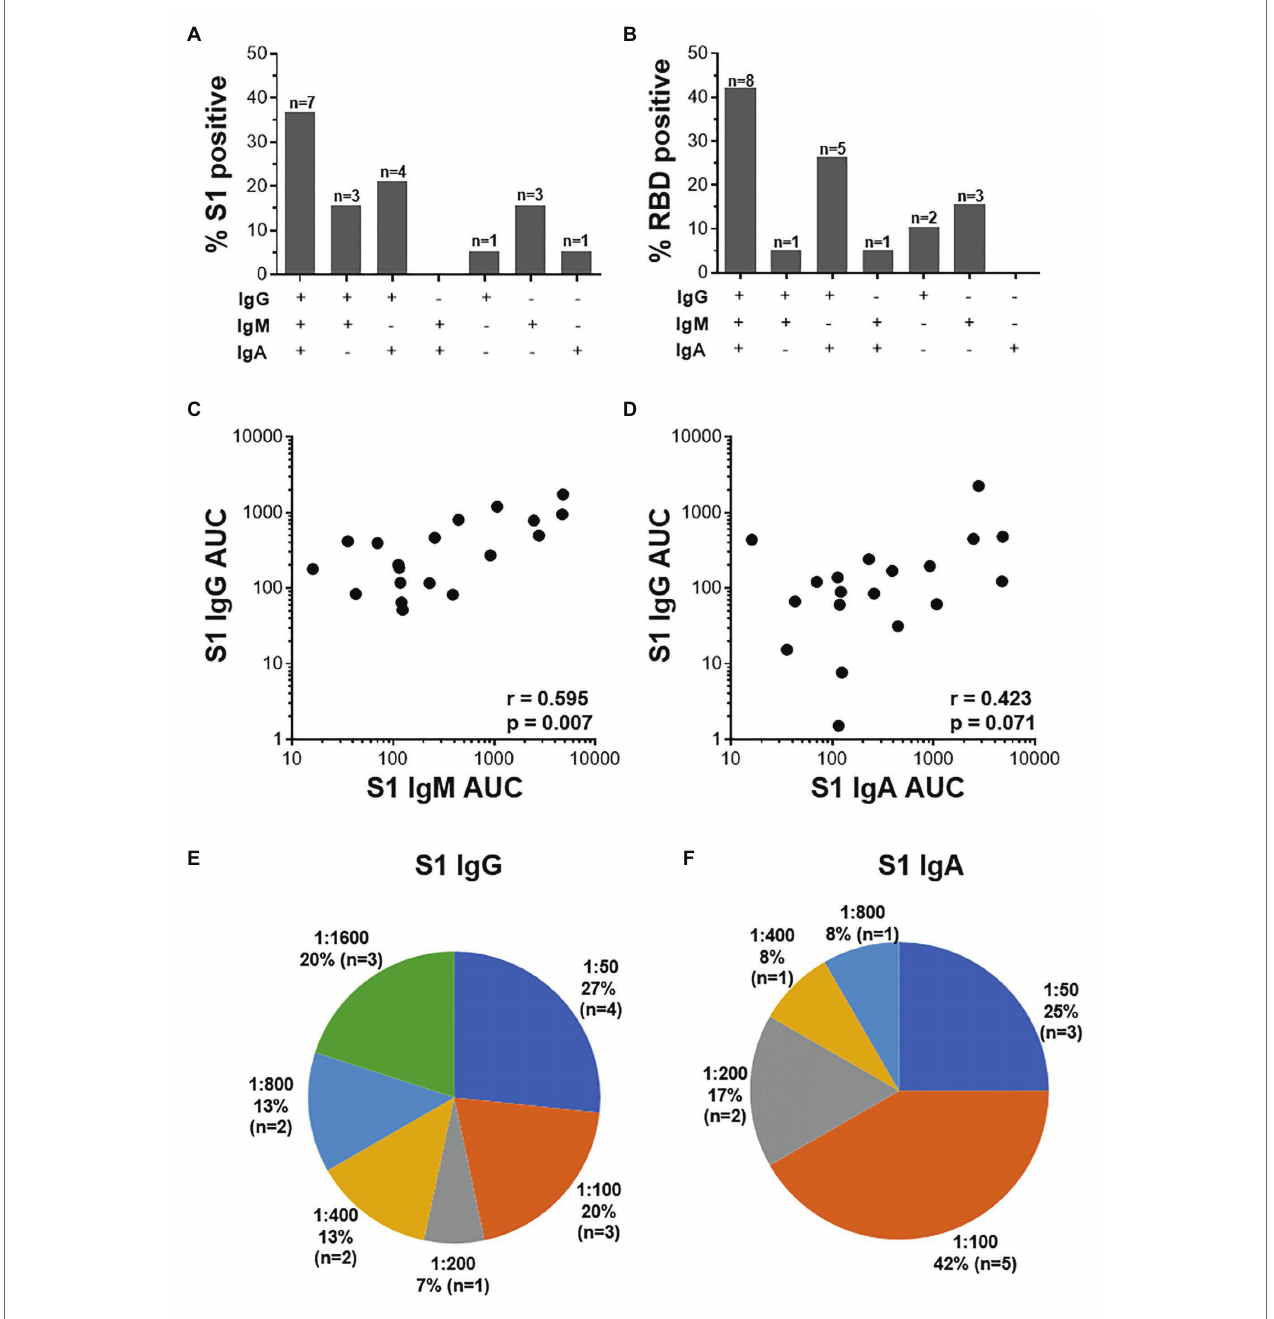
FIGURE 5 | The relationship between IgG, IgM, and IgA responses to S1 and RBD SARS-CoV-2 antigens. (A) Proportions of COVID-19 convalescent volunteers mounting different combinations of IgG, IgM, and IgA specific for S1 ( A ; n = 19) and RBD ( B ; n = 20). Relationship between S1-specific IgG and IgM (C) and IgG and IgA (D) . Statistical analyses were performed using a non-parametric Spearman rank correlation. Proportion of convalescent volunteers with endpoint titers for IgG (E) and IgA (F) of 1:50, 1:100, 1:200, 1:400, 1:800, and